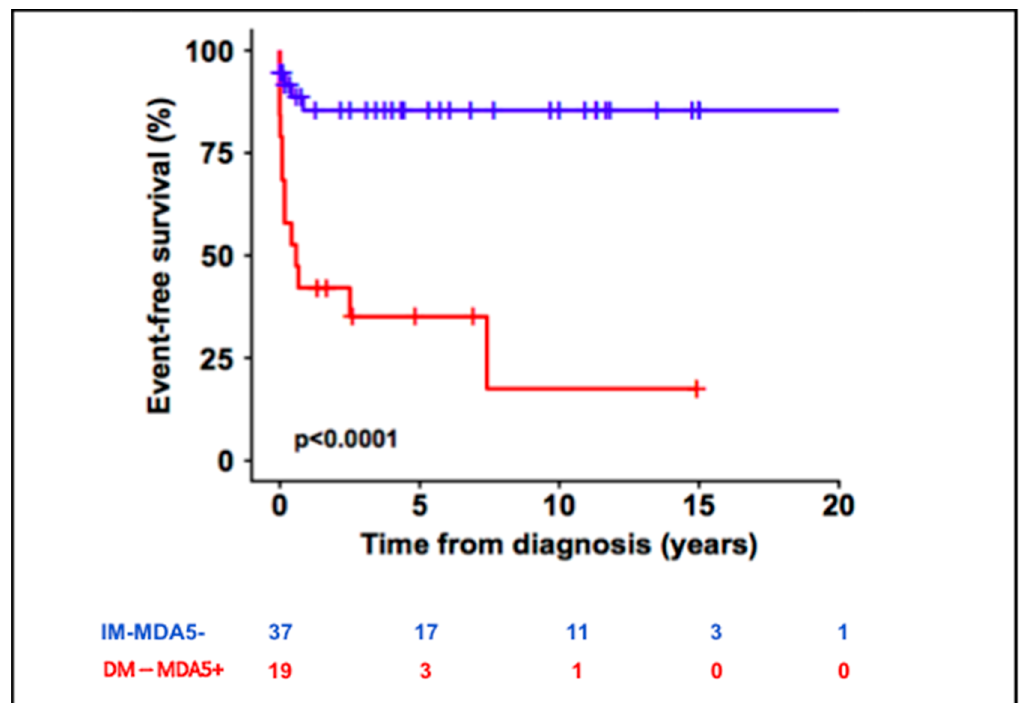
Figure 1. Significant infectious complications (SIC)-free survival curve in DM-MDA5+ and IM- MDA5 − patients.